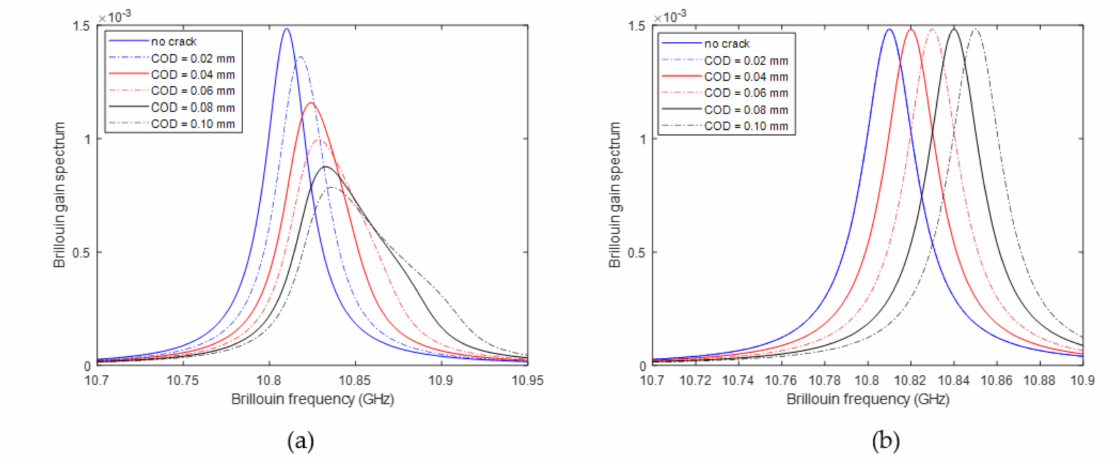
Figure 10. Changes of BGS of fiber at location of ( a ) with crack ( b ) without